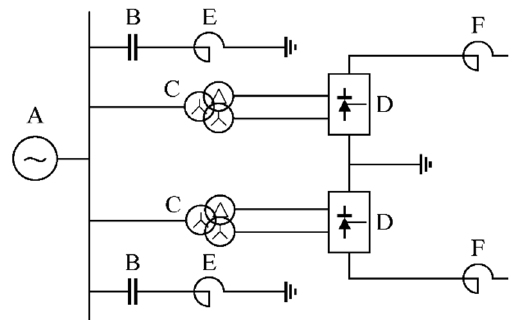
Figure 1. Electromagnetic disturbance sources distribution in the converter station. ( A ) Electromagnetic disturbance signals generated by generators and switchgear in power plants. ( B ) The electromagnetic disturbance signal generated by the isolation switch, switch, capacitor, etc. in the line. ( C ) High-energy surge pulse generated by the excitation inrush current when the transformer is switched on and off. ( D ) High-frequency pulses and surge impact signals generated by power electronic equipment, such as thyristors during transient conversion. ( E ) Magnetic field disturbance generated in steady-state operation of the line, and high-frequency disturbance generated in a fault state. ( F ) High-frequency disturbance signal generated by bus switching.